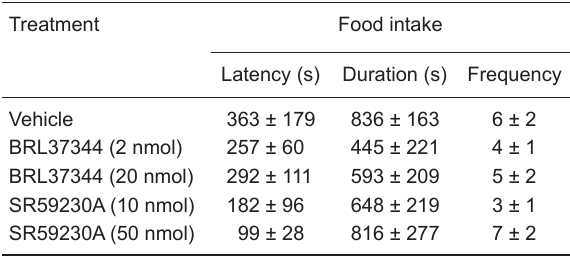
Table 1. Effects of icv injection of BRL37344 (a β 3 -adrenergic agonist) or SR59230A (a β 3 -adrenergic antagonist) on feeding behavior of 24-h fasted